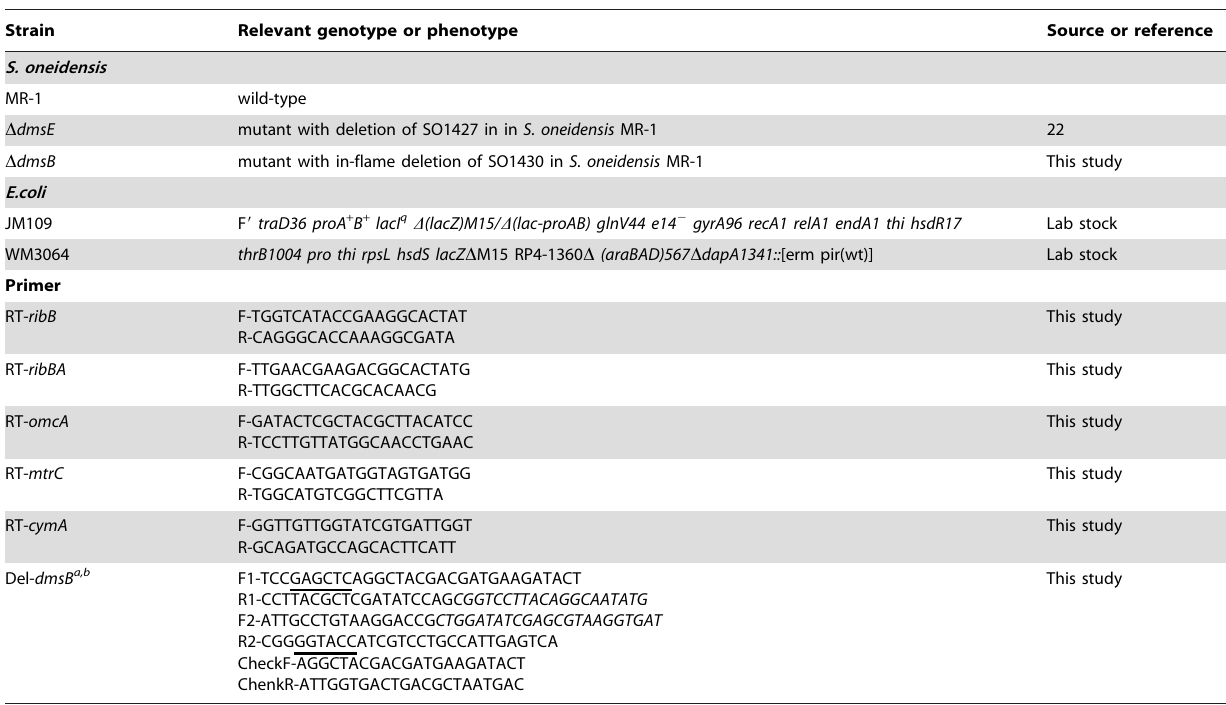
Table 1. Strains, plasmids and primers used in this